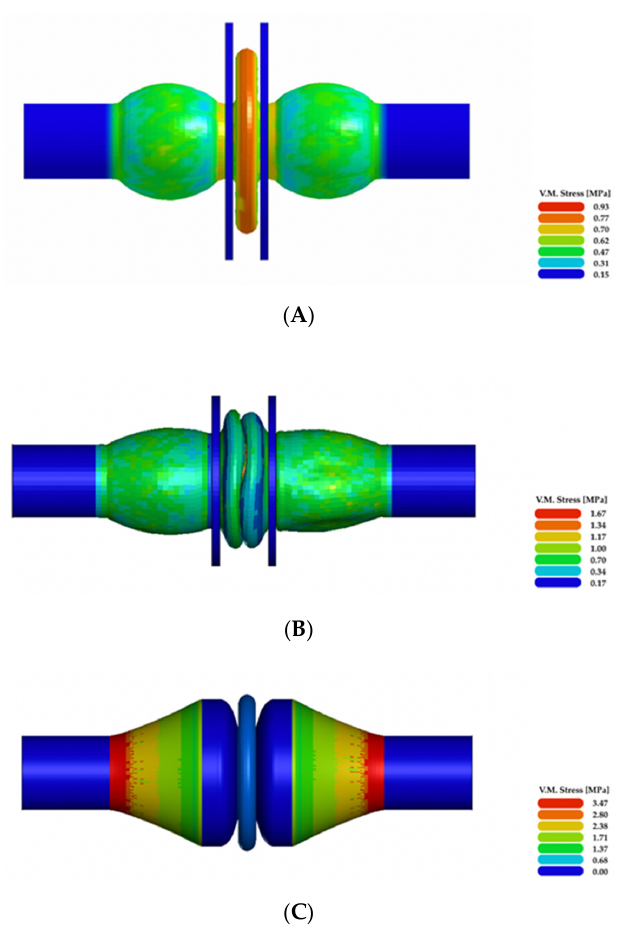
Figure 10. Results of the numerical simulations: ( A ), ( B ), and ( C ) illustrate Von Mises effective stress at the maximum compression of the three simulated ventricular chamber configurations.